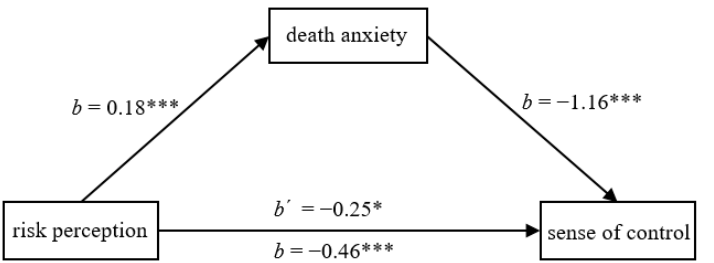
Figure 1. Death anxiety partially mediated the effect of risk perception on sense of control in Study 3a. * p < 0.05, *** p < 0.001.